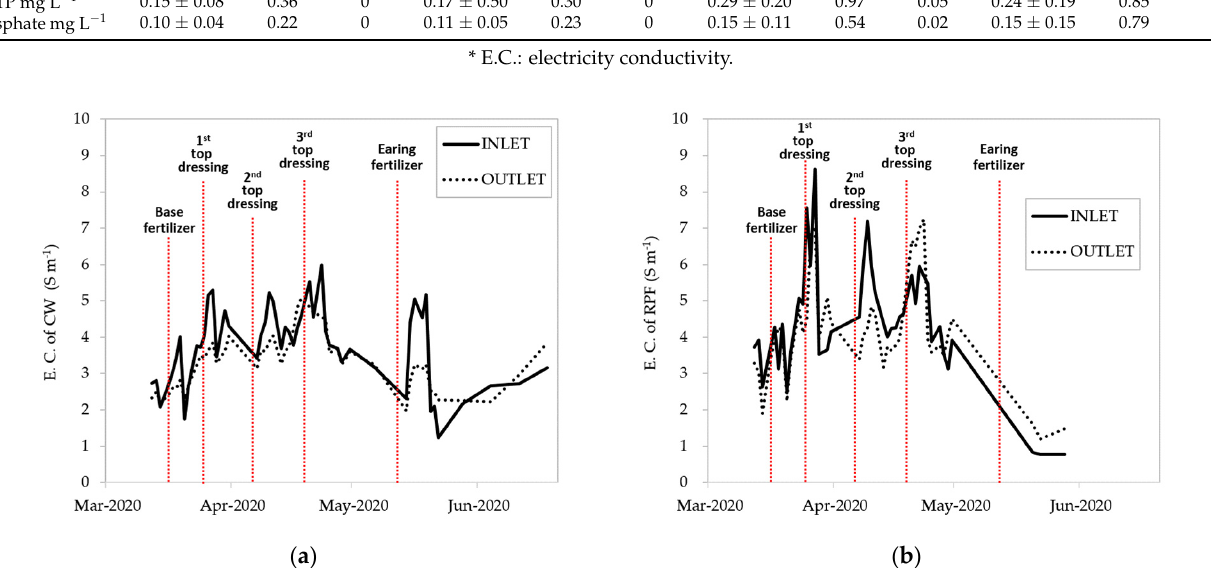
Figure 3. E.C. of INLET and OUTLET in ( a ) CW treatment and ( b ) RPF treatment of first crop season, 2020 (March–June); each fertilization timing is marked.